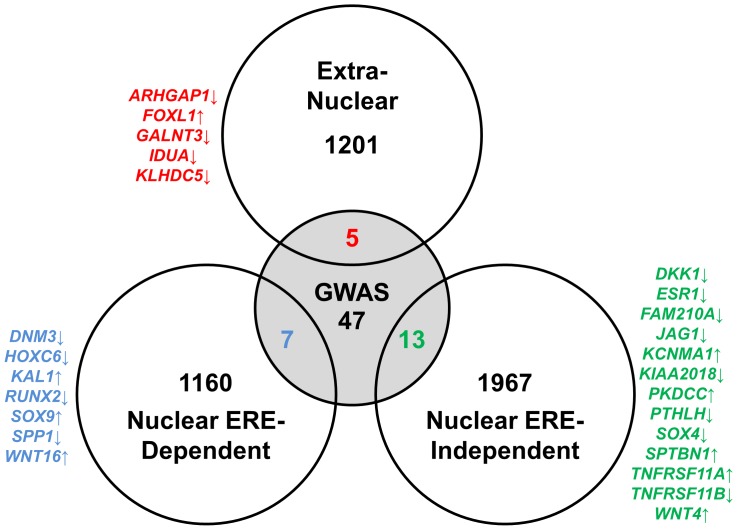
Comparison of the RNAseq datasets to gene with known involvement in bone biology from genome-wide association studies (GWAS).The nuclear ERE-dependent, nuclear ERE-independent, and extra-nuclear datasets were intersected with the 72 genes identified by GWAS studies. The overlapped genes for each mode of ERα action are listed and color-coded for clarity. The directionality of the estrogen-dependent regulation is denoted with an arrow following the gene symbol.